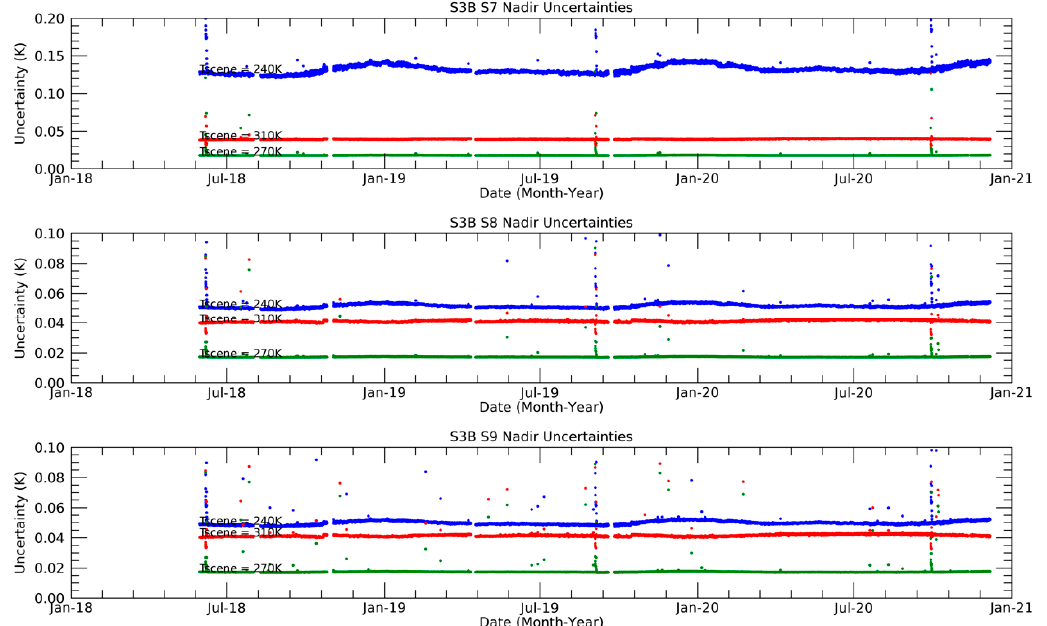
Figure 16. Correlated Time series for the period from May 2018 to December 2020 of SLSTR-B Thermal Infrared Radiometric Uncertainties for scene temperatures of 240 K (blue), 270 K (green) and 310 K (red).